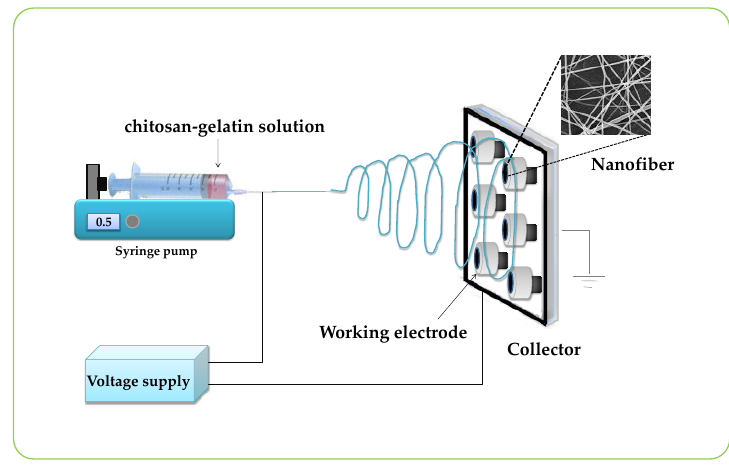
Figure 1. Schematic drawing of the electrospinning system.